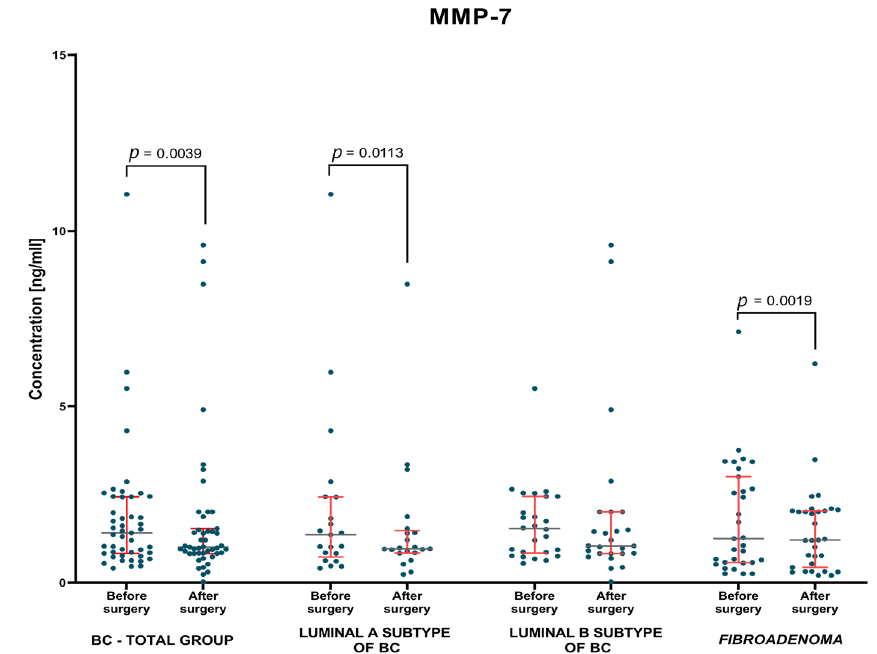
Figure 5. MMP-7 plasma concentrations (with marked median and interquartile range) in patients (total group and subgroups) with BC and fibroadenoma subjects before and after surgery. Significant statistical differences have been marked on the figure.